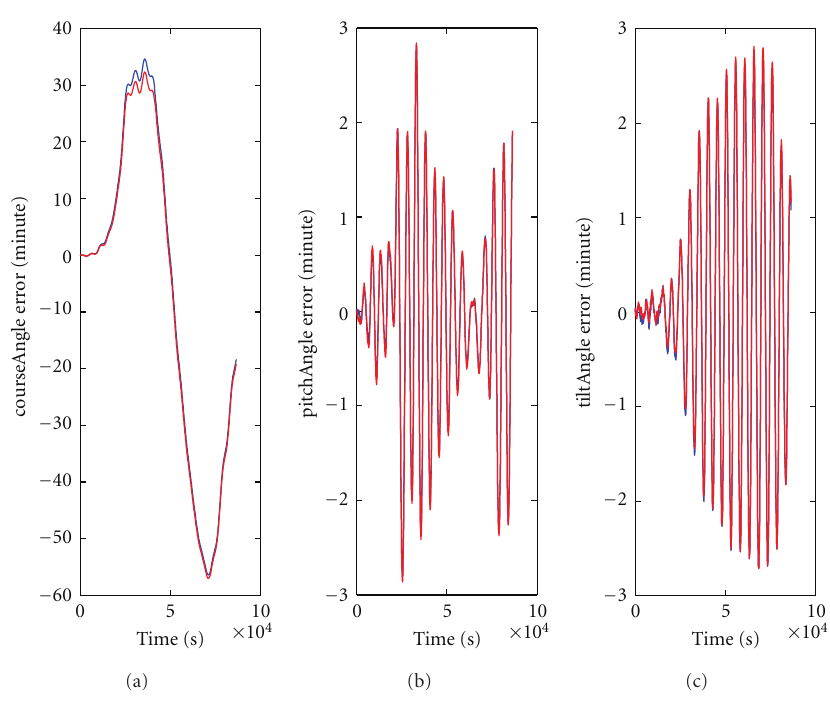
Figure 22: Angle error of real data set